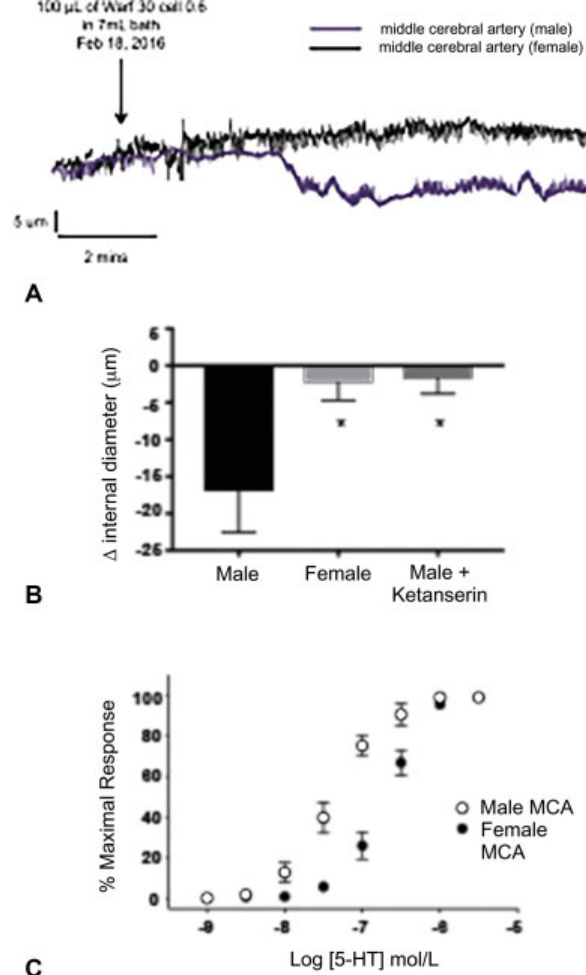
Fig. 2 ( A ) Representative pressure myography traces and ( B ) sum- mary data demonstrating the 5-HT-dependent constrictive effects of warfarin (30 μ g/mL) inhibited platelet releasates on male, but not on female, rat middle cerebral arteries. N ¼ 4 for each sex. (cid:1) p < 0.05. ( C ) Concentration responses experiments demonstrating vasocon- striction to 5-HT of male versus female rat MCAs. N ¼ 5 for each sex. 5-HT,